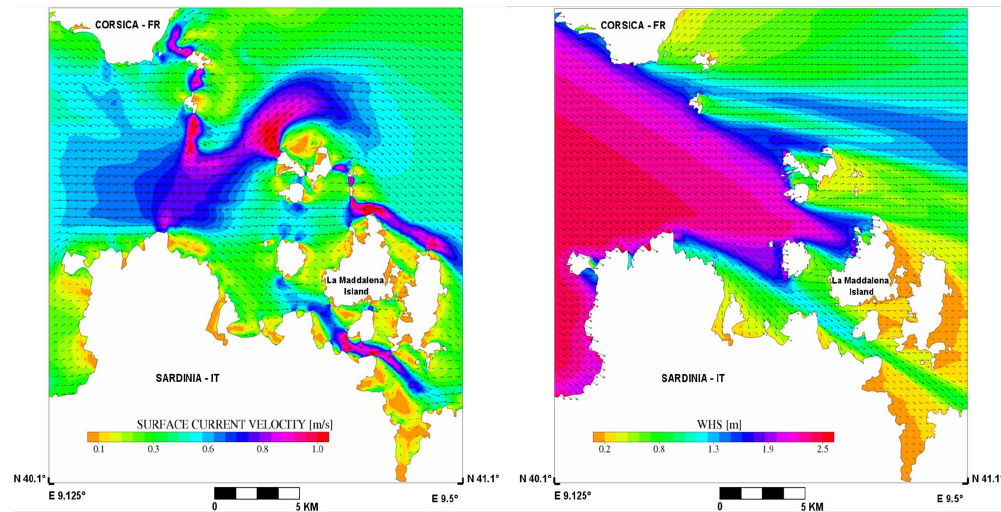
Fig. 7. Surface current speed and significant wave height induced by a 13ms − 1 Mistral wind in the Bonifacio Strait and La Maddalena archipelago